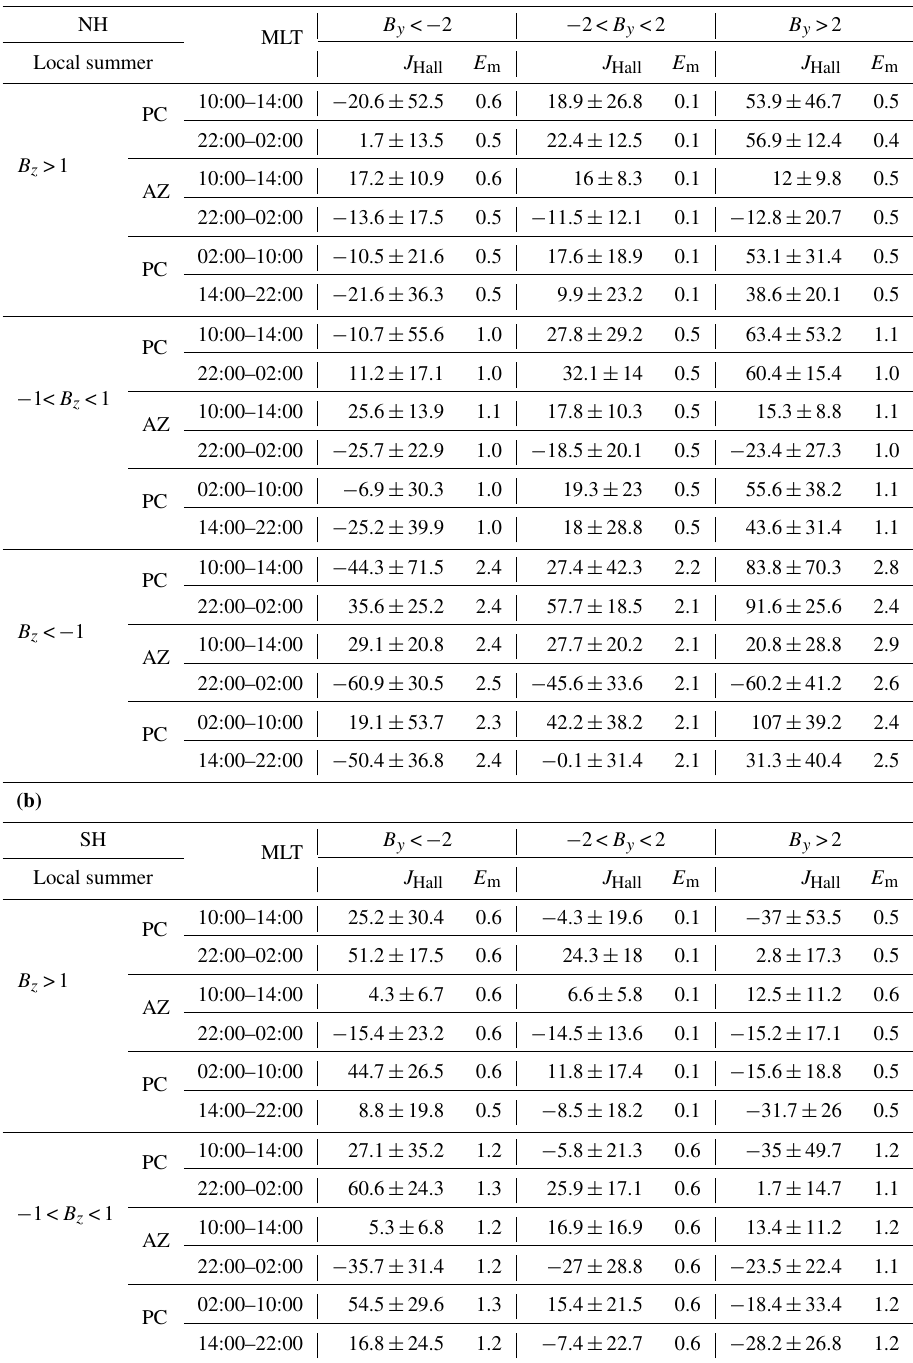
Table 1. (a) Northern Hemisphere summer average Hall current density for different IMF directions as in Fig. 3a. The results are sorted into two latitude ranges: polar cap (PC, MLAT>70 ◦ ) and auroral zone (AZ, 60 ◦ ≤ MLAT ≤ 70 ◦ ) regions. The data are sorted into four MLT sectors (dawn: 02:00–10:00MLT; noon: 10:00–14:00MLT; dusk: 14:00–22:00MLT; midnight: 22:00–02:00MLT). Averages of Hall current densities and related uncertainties are given in units of mAm − 1 . The merging electric field, E m , is given in units of mVm − 1 . The positive (negative) values indicate eastward (westward) Hall currents. (b) Same format as Table 1a, but for Southern Hemisphere local summer conditions. (c) Same format as Table 1a, but for Northern Hemisphere winter conditions. (d) Same format as Table 1a, but for Southern Hemisphere winter